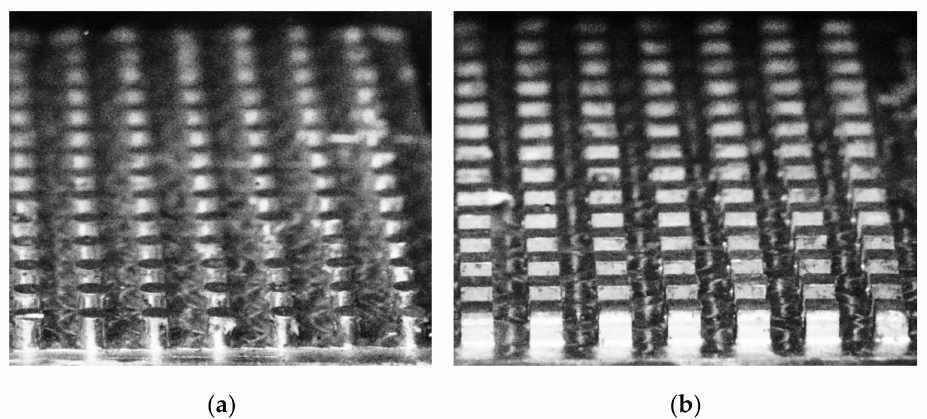
Figure 5. Phenomenon of isolated bubble regime observed from: ( a ) 1 mm gap circular pin fin array at q” = 5.8 W/cm 2 ; ( b ) 1 mm gap rectangular pin fin array at q” = 5.1 W/cm 2